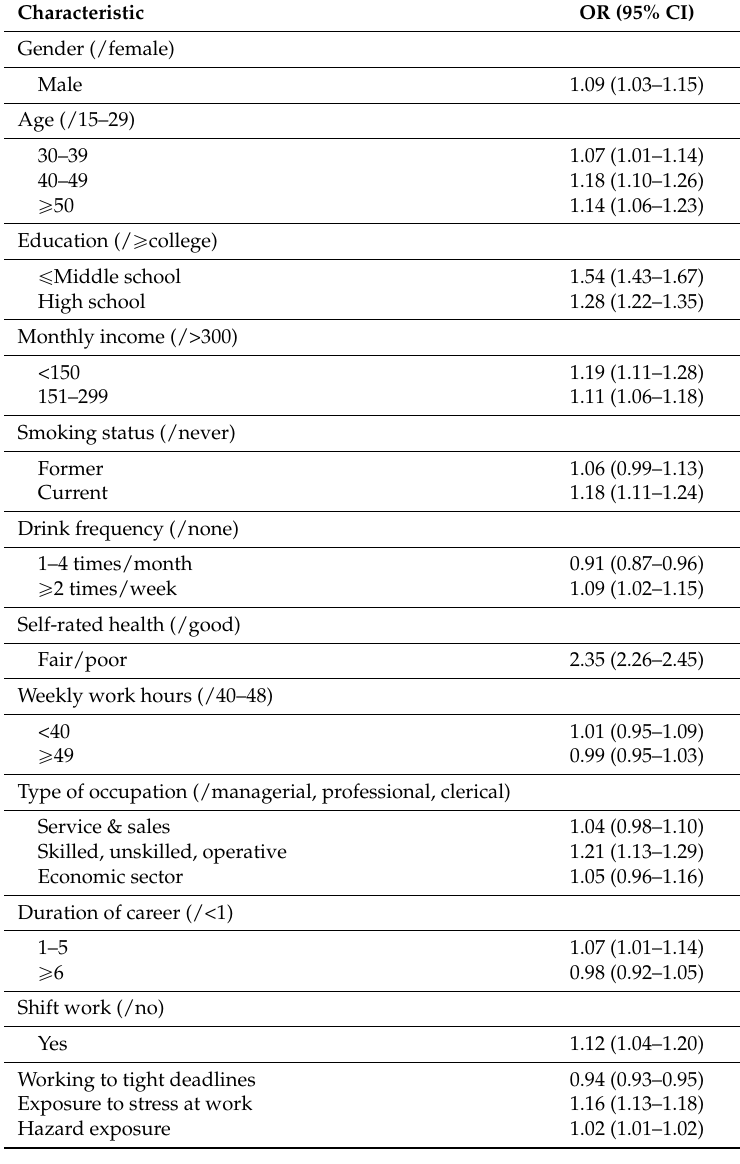
Table 3. Odds ratios (95% CI) for depressive